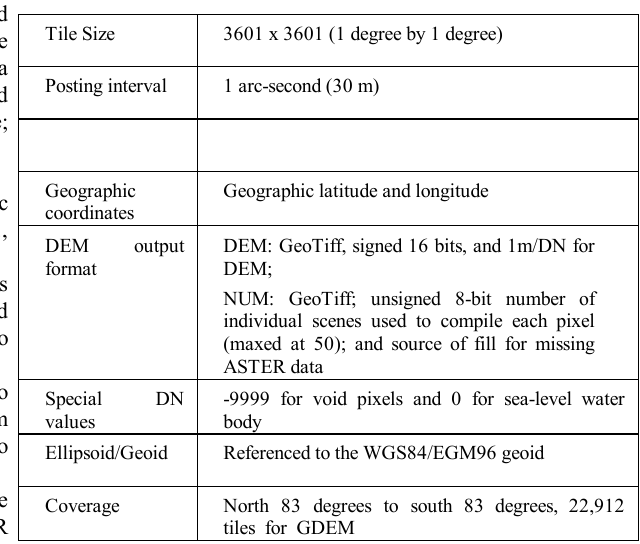
Table 1 . Characteristics of ASTER GDEM Version